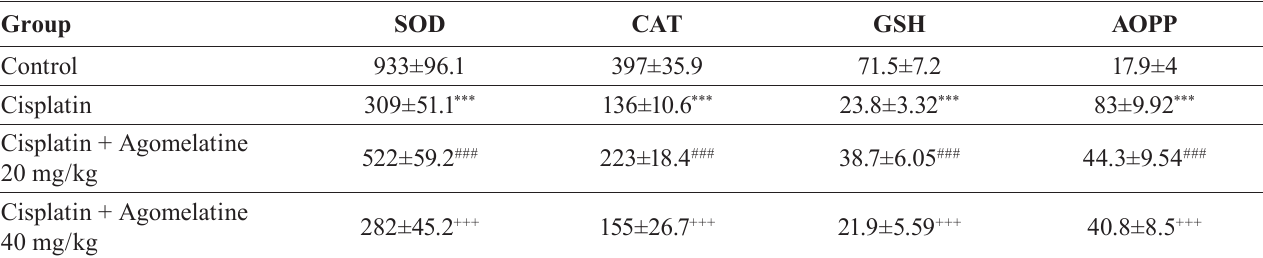
All data expressed as mean±SD. ***p<0.001 versus control group and ### p<0.001 versus cisplatin group and +++ p<0.001 versus cisplatin+agomelatine (20 mg/kg)